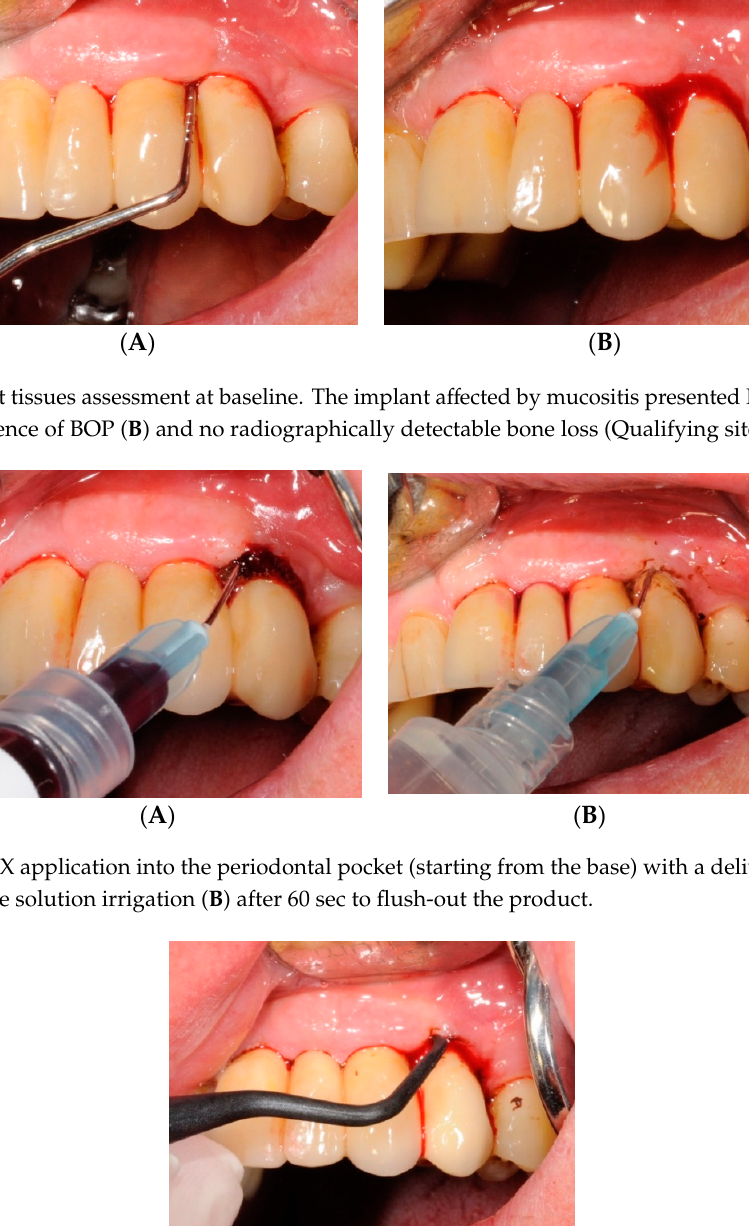
Figure 4. Clinical photograph ( A ) and radiograph ( B ) of a female patient at baseline (T0). The patient presented locking-taper implants in the upper jaw. One implant (site 2.4) affected by mucositis was treated with HBX (Test-Group).